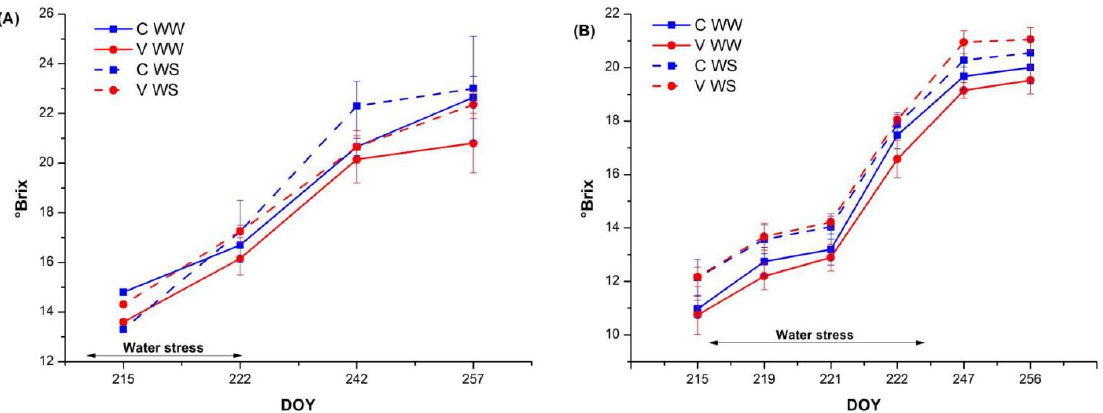
Figure 3. Evolution of total soluble solid content ( ◦ Brix) in Sangiovese berries sampled in closed (C) and V (V) canopy-shaped vines under normal water supply (WW) or water stress at veraison (WS) in 2018 ( A ) and 2019 ( B ) seasons. Error bars indicate the mean SE (n = 4). Means followed by different letters differ significantly, as calculated by Tukey test ( p ≤ 0.05). The duration of the water stress period is indicated by black double arrows.